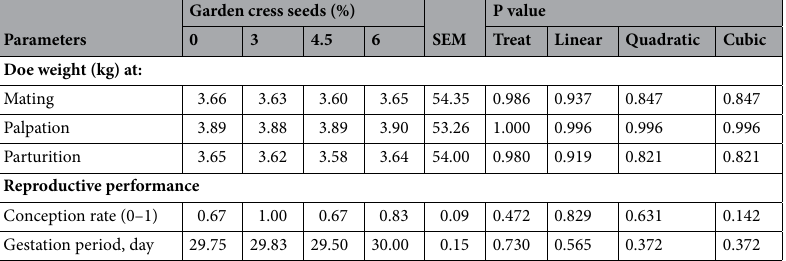
Table 2. Effect of dietary levels of Garden grass levels on female rabbit body weight and reproductive parameters of female’s rabbits. SEM stander error means.